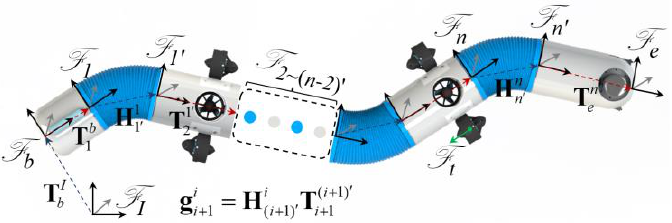
Figure 3. Schematic diagram of underwater rigid-soft snake robot model, where white parts are rigid propulsions and blue parts are soft joints.